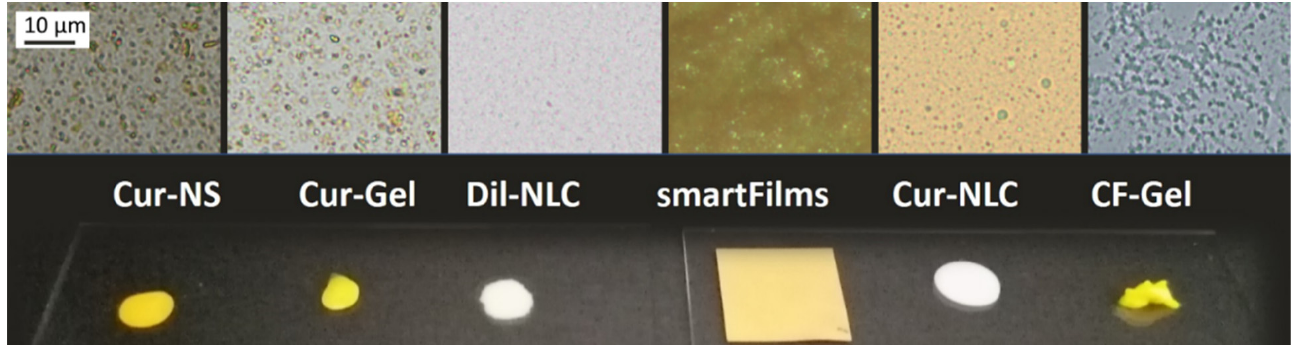
* 1,1 ′ -dioctadecyl-3,3,3 ′ ,3 ′ -tetramethylindo-carbocyanin perchlorate. ** aqueous phase consisted of poloxamer 188 (3.0%), polysorbate 80 (0.1%), polyvinyl pyrrolidone 10,000 (0.1%), TPGS (1.0%) and